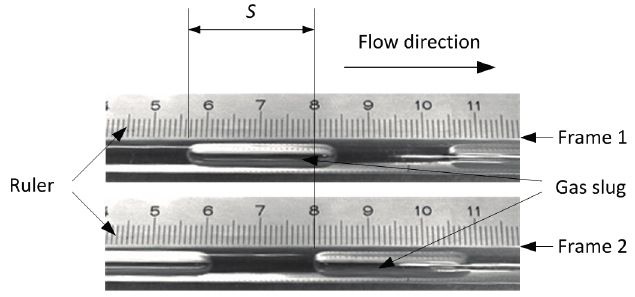
Figure 11. The images of gas slugs passing through the testing pipe.